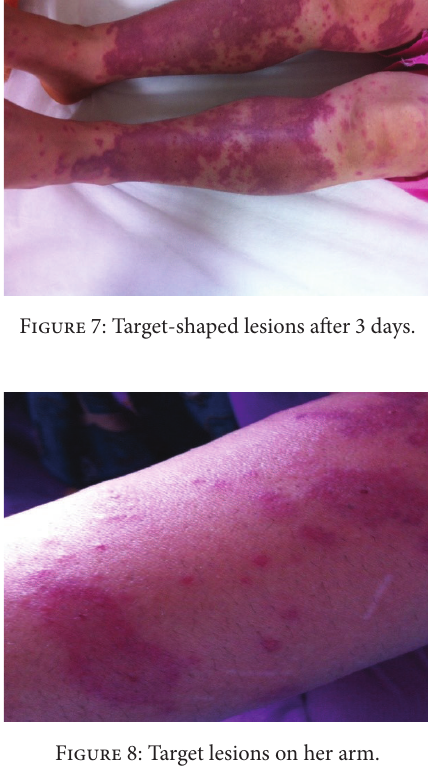
Figure 10: Three weeks after initial lesion.